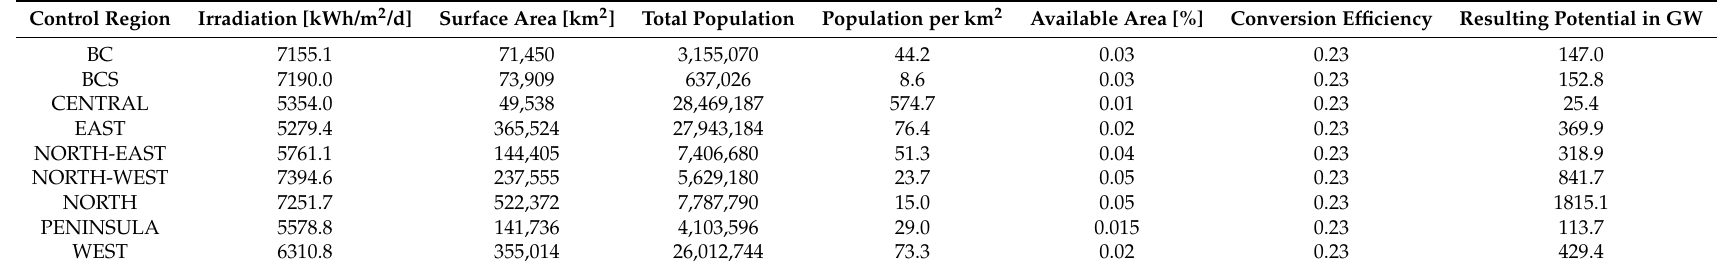
Table A5. Data and assumptions used for the computation of solar PV